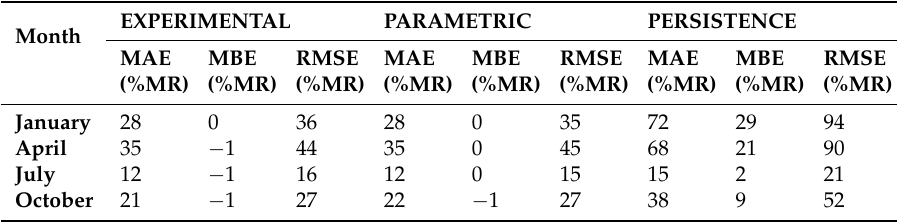
Table 4. Monthly mean values of MAE j , m , MBE j , m and of RMSE j , m for the months in Figure 7. EXPERIMENTAL Month